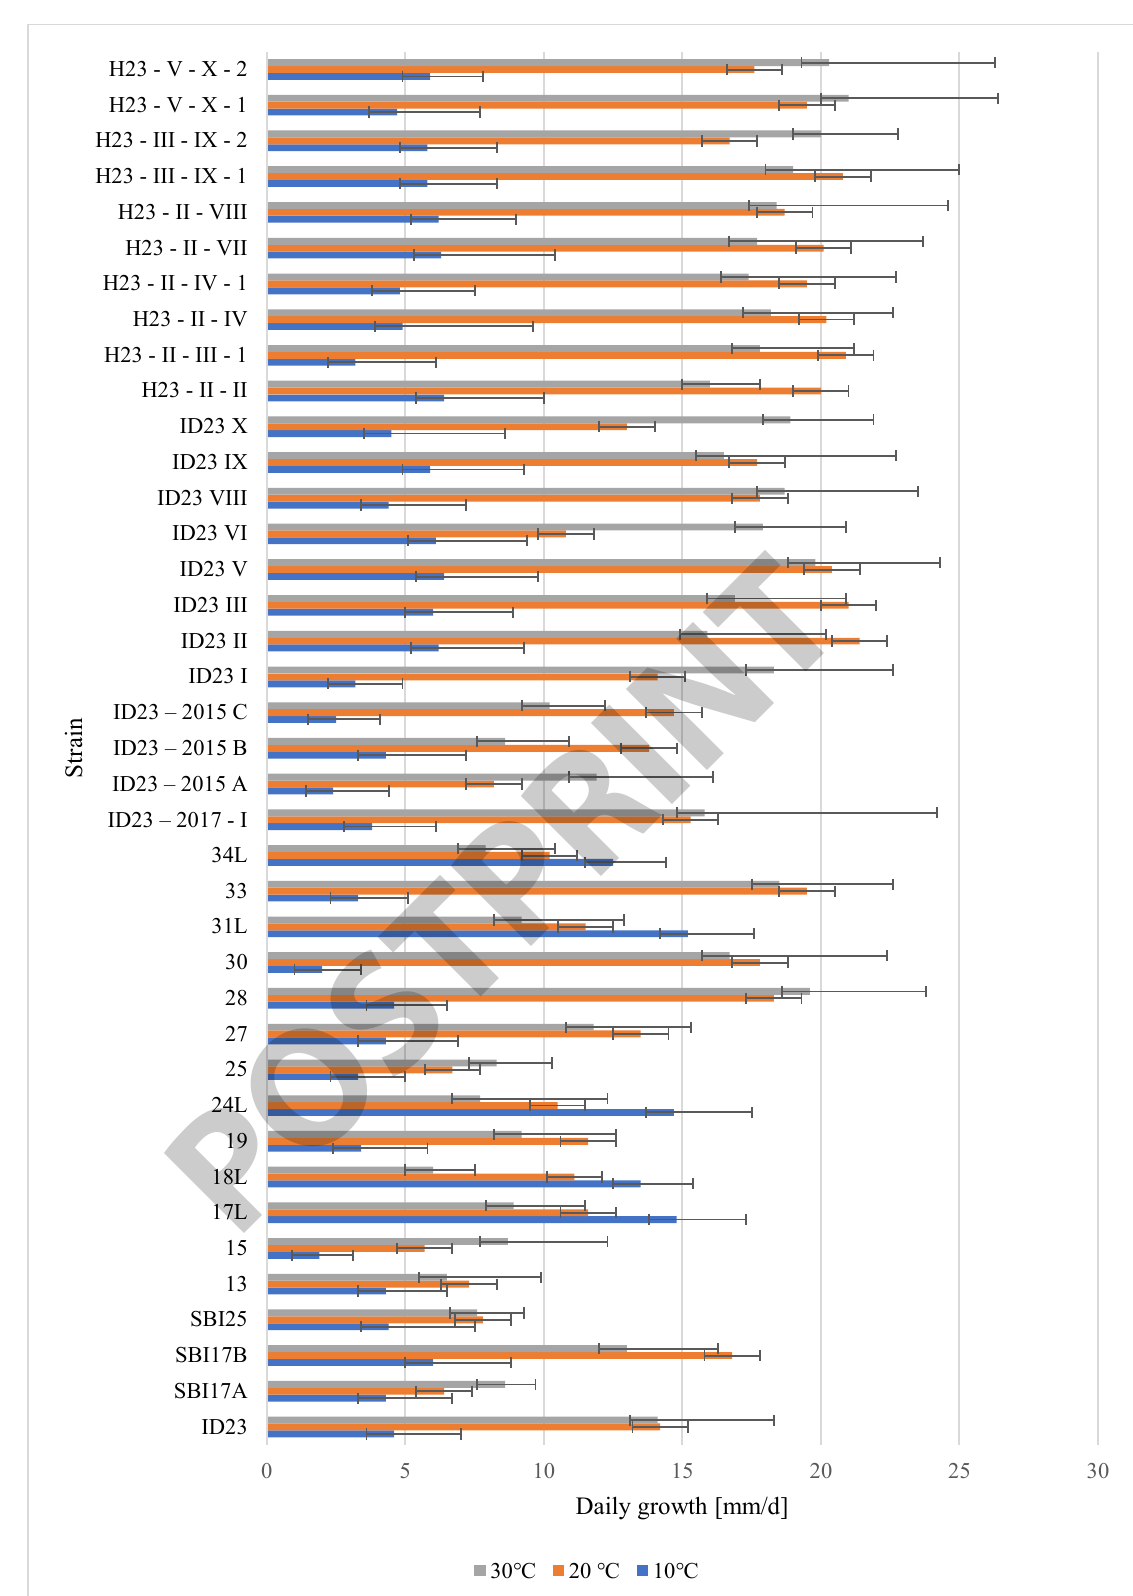
Figure 2. I nfluence of temperature on the average daily growth (mm/ d ) of tested mycelia AG5 group of R.